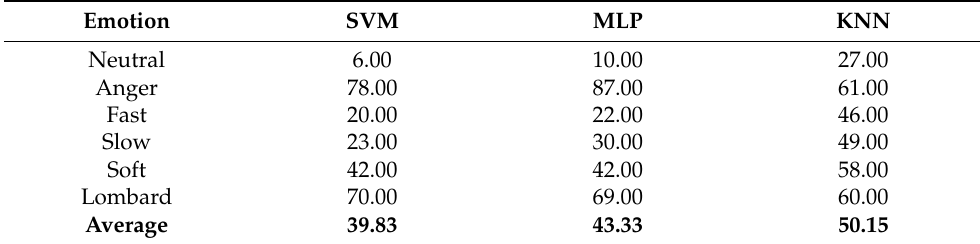
Table 7. Percentage EER using SVM, MLP, and KNN classifiers using the SUSAS database.